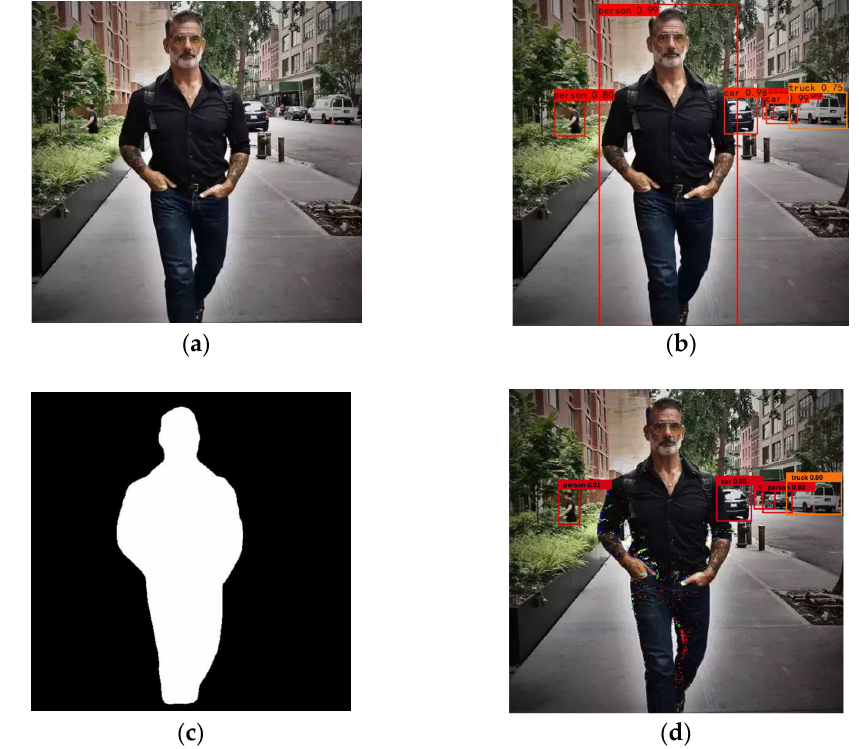
Figure 2. Adversarial examples can successfully deceive detectors: ( a ) is a clean picture; ( b ) shows that the detector can successfully detect all objects in the image when the image is not under attack; ( c ) is the generation of the mask matrix of the attacked object based on the segmentation algorithm; ( d ) shows the attack results. The detector cannot detect the specific object but can correctly detect other objects.